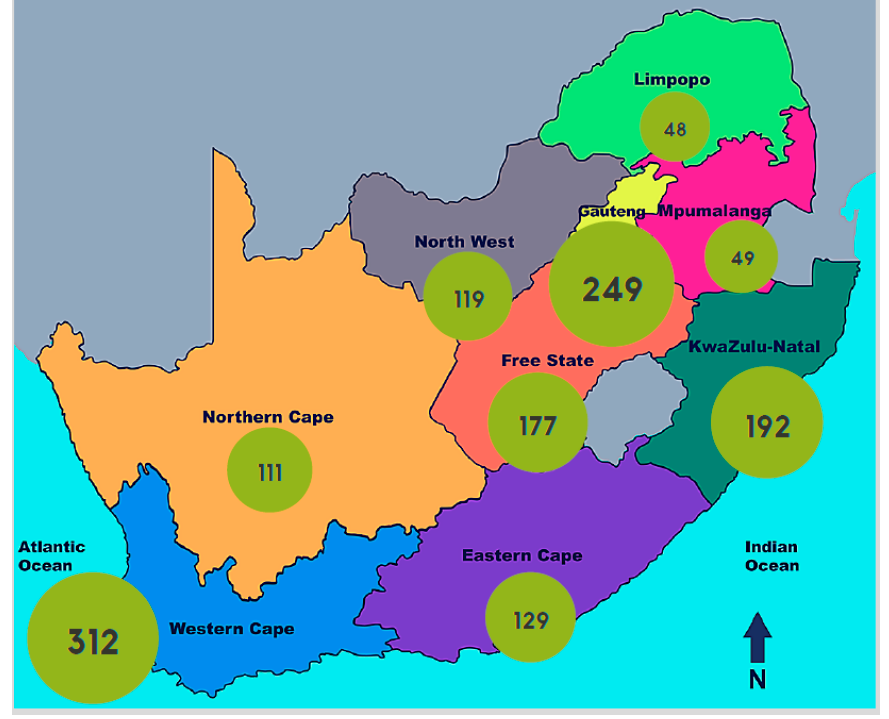
Figure 3. Geographical inequities in access to dialysis per million population in South Africa.